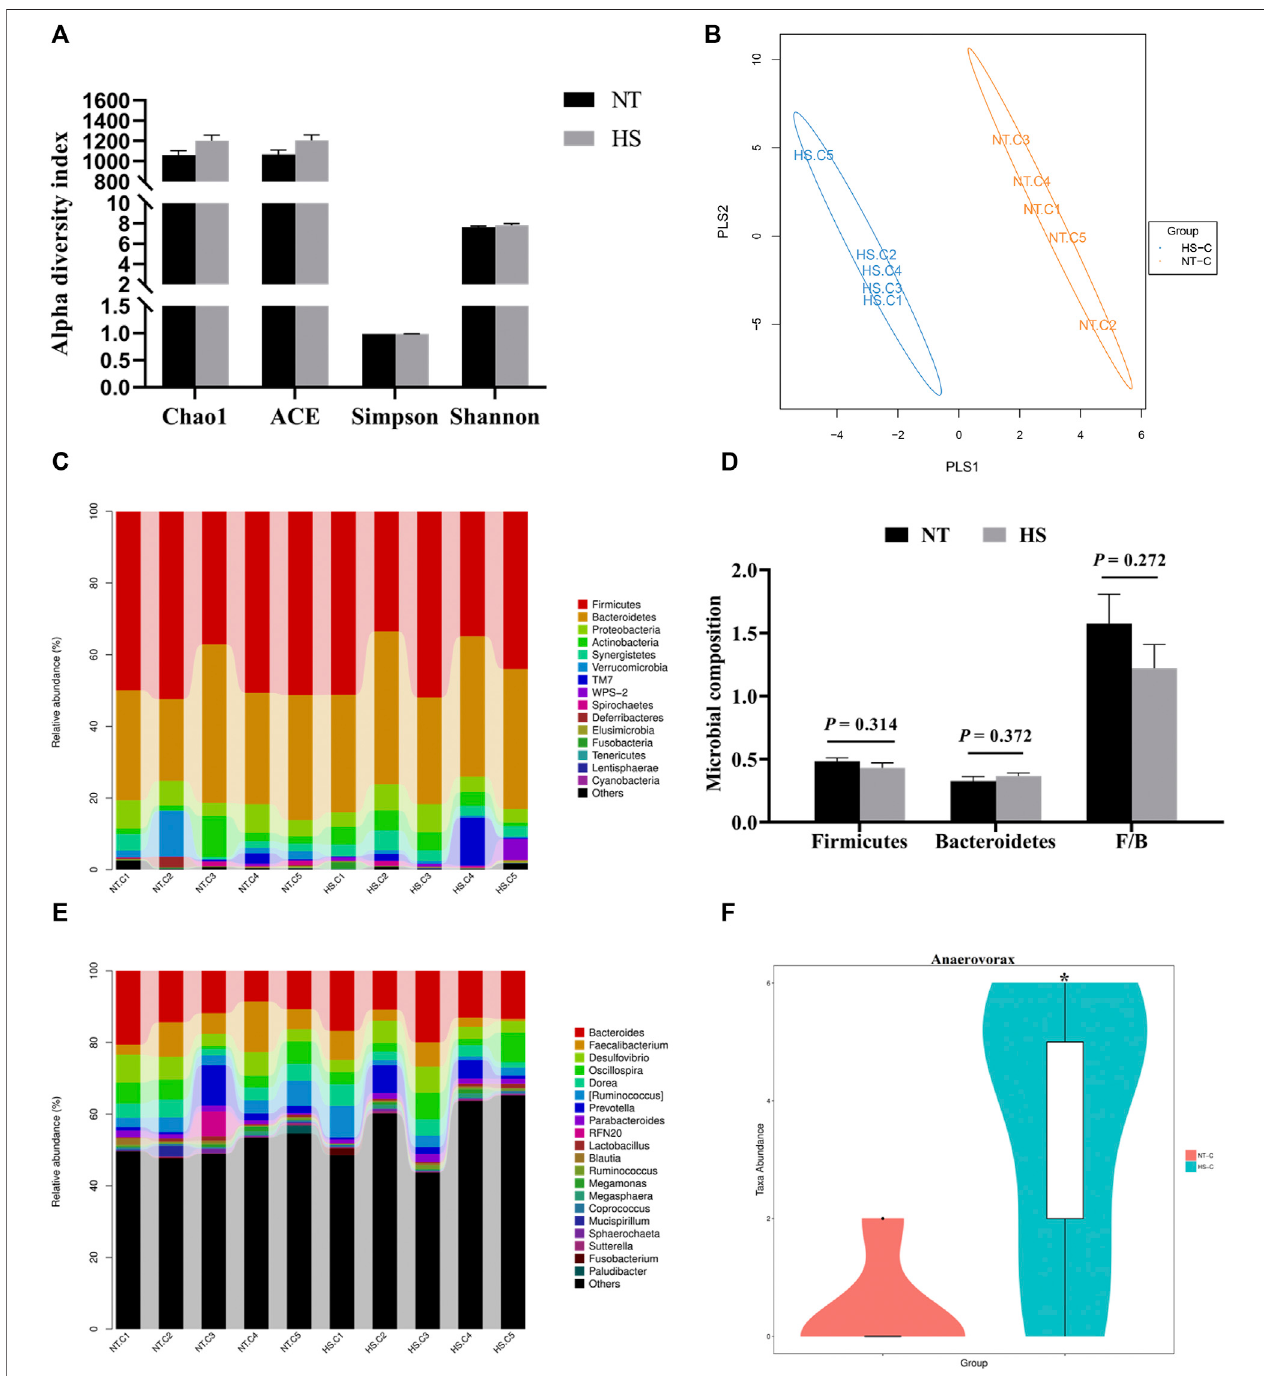
FIGURE 4 | Effects of heat stress on cecal microbial community in indigenous broilers (n = 5/group). (A) alpha diversity; (B) beta diversity; (C) cecal microbial composition at the phylum level; (D) impacts of HS on the cecal relative abundance of Firmicutes , Bacteroidetes and the ratio of Firmicutes/Bacteroidetes (F/B) at the phylum level; (E) cecal microbial composition at the genus level; (F) impacts of HS on the cecal relative abundance of Anaerovorax at the genus level; NT, normal treatment group (21.3 ± 1.2 ° C, 24 h/day), HS, heat stress group (32.5 ± 1.4 ° C, 8 h/day). * p < 0.05.